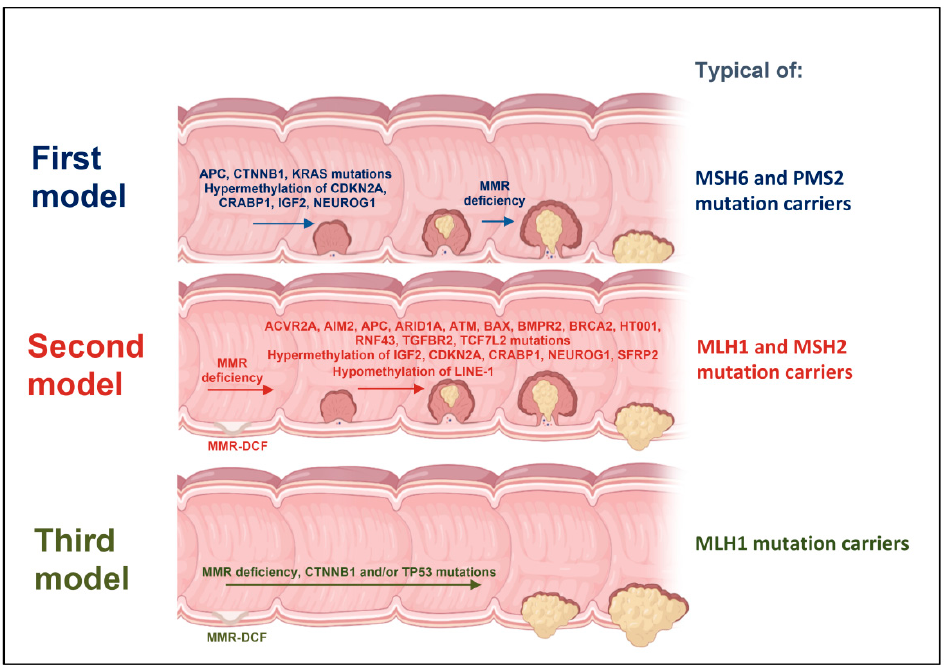
Figure 2. Three different models of colorectal carcinogenesis in Lynch syndrome patients.